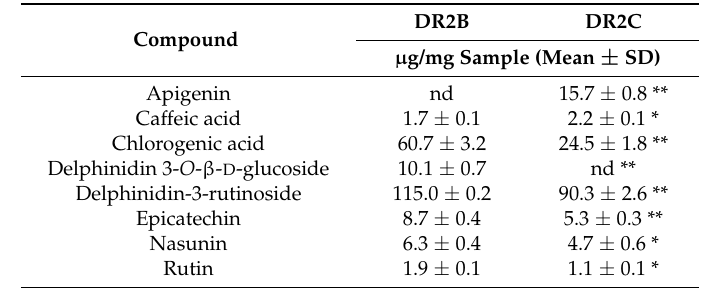
Table 2. Levels of polyphenols and anthocyanins measured by the HPTLC densitometric analysis in DR2B and DR2C extracts ( n =